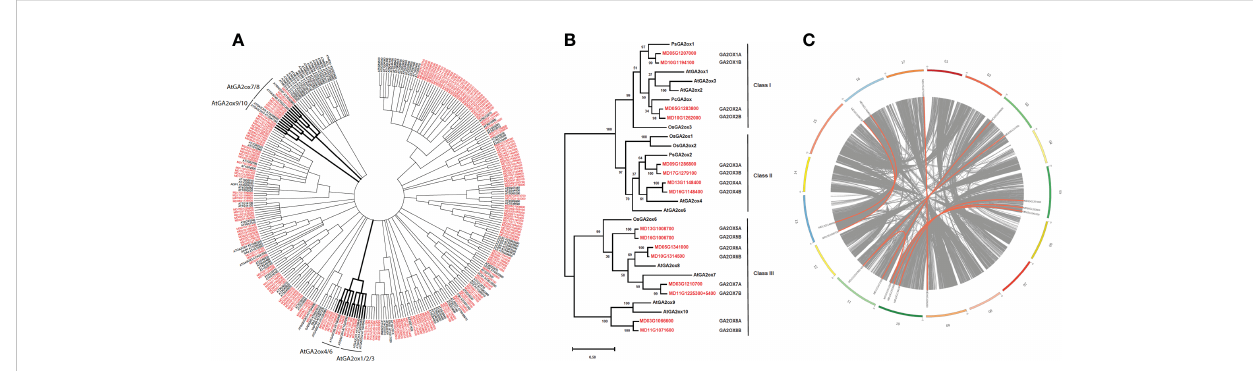
FIGURE 1 Phylogenetic analyses of GA2ox-related protein sequences. (A) Phylogenetic analyses of GA2ox-related protein sequences identi fi ed by BLASTp. Apple and Arabidopsis sequences are shown in red and black font, respectively. Clades containing canonical GA2ox representatives from Arabidopsis are shown in bold. A bootstrap cutoff value of 70 was used to de fi ne branches. (B) Phylogenetic tree of apple GA2ox protein sequences (red font) and characterized GA2ox proteins from Arabidopsis, rice, pea and bean. (C) Circos plot showing chromosomal position of the MdGA2ox genes with respect to homeologous chromosomes, which are designated with similar color. Homeologous genes are connected with an orange